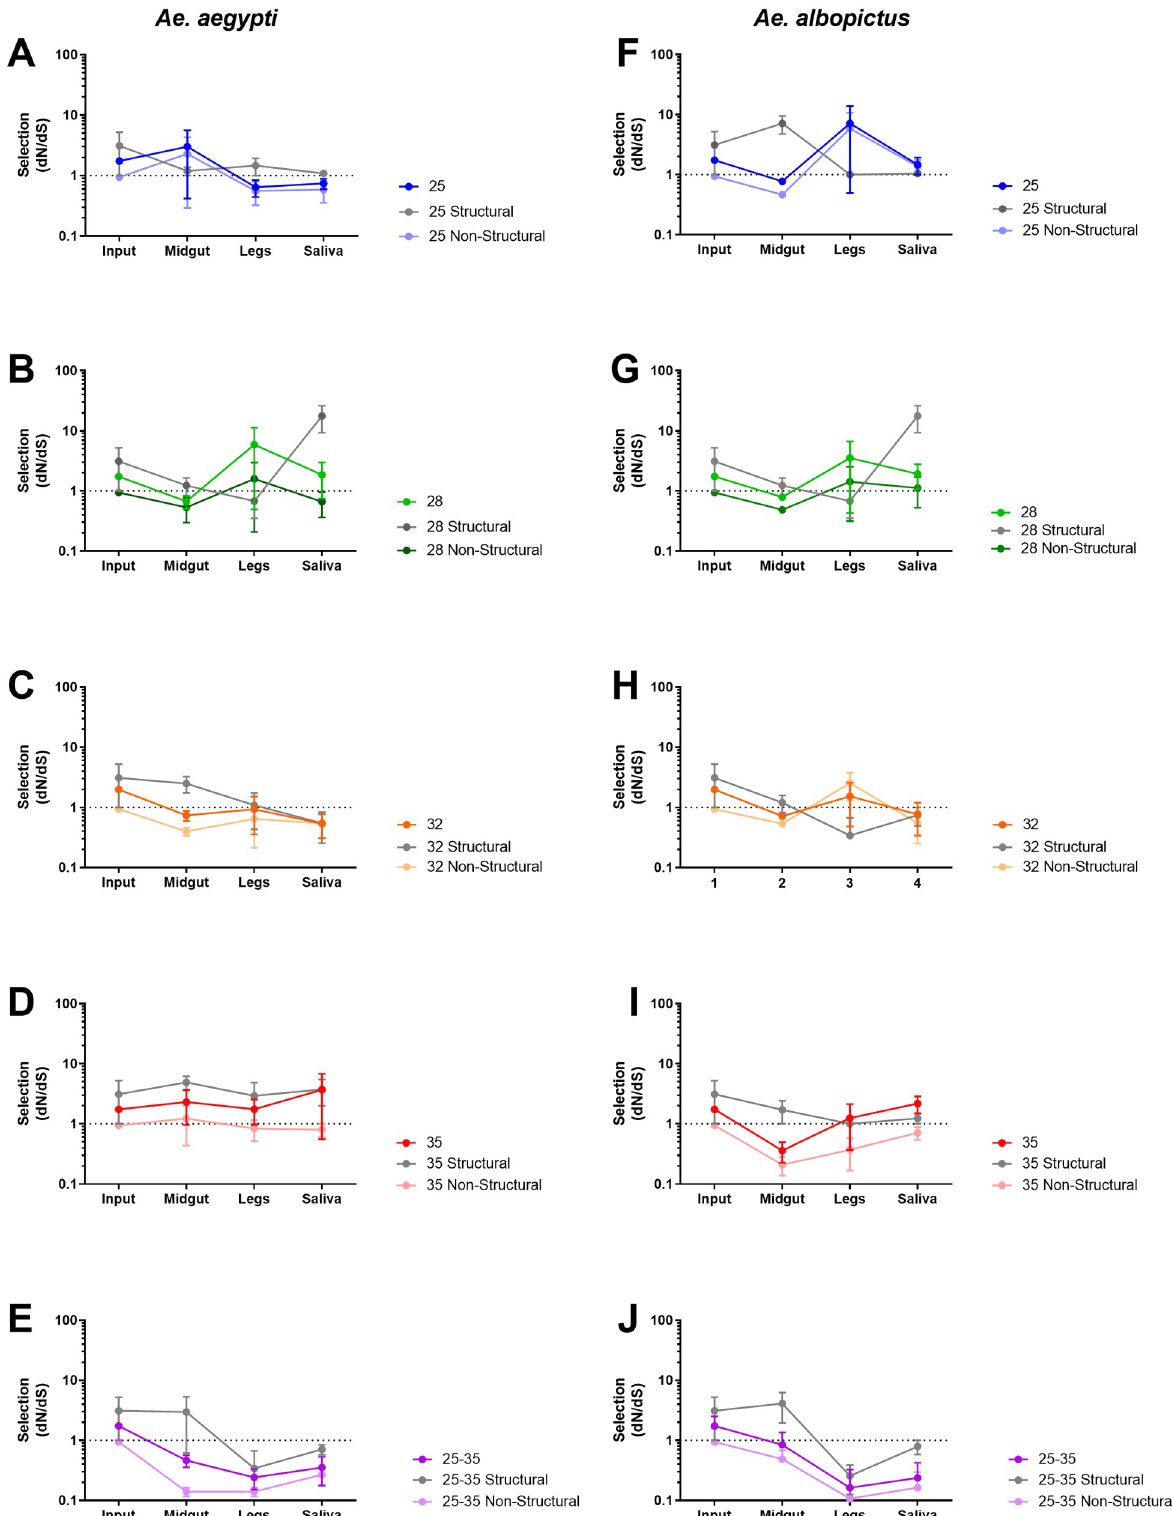
Fig 3. Fluctuating extrinsic incubation temperatures impose purifying selection on ZIKV during systemic mosquito infection. d N /d S (mean with SEM) for ZIKV CDS (closed circles), structural sequence (Boxes), and non-structural sequence (open circles), at indicated EITs including fluctuating EITs, in Ae . aegypti (A-E) and Ae . albopictus (F-J). https://doi.org/10.1371/journal.ppat.1009433.g003 PLOS Pathogens| https://doi.org/10.1371/journal.ppat.1009433 November 9,